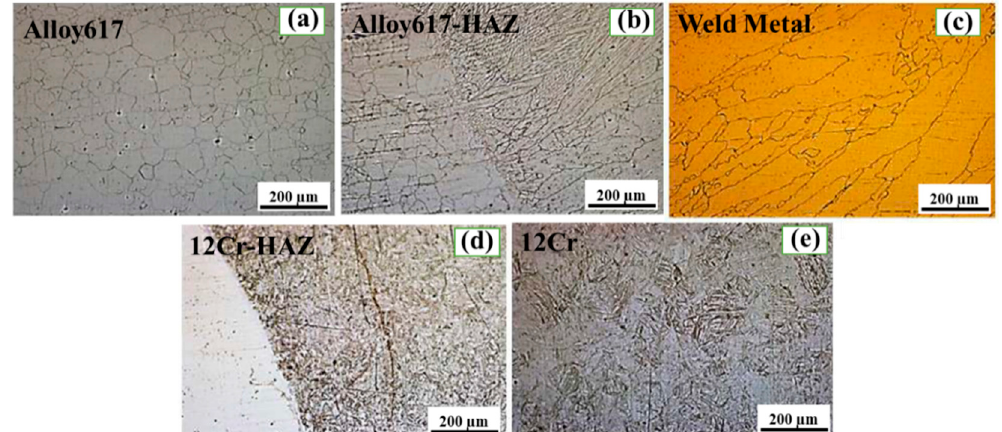
Figure 2. Optical micrographs of important regions before post weld heat treatment (PWHT): ( a ) Alloy 617, ( b ) Alloy617-HAZ, ( c ) Weld metal, ( d ) 12Cr-HAZ and ( e ) 12 Cr. Table 2. EDS elemental characterization of materials before and after